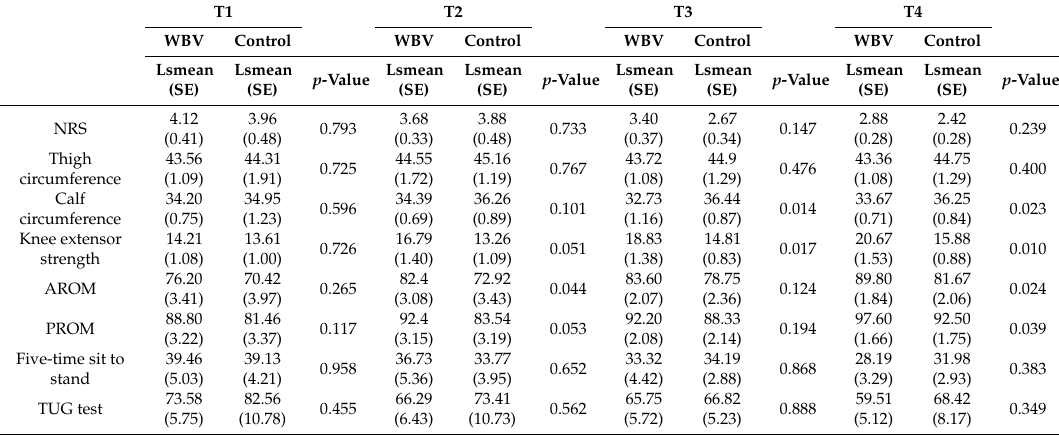
Table 2. Di ff erences between groups in serial testing of all outcome measures.